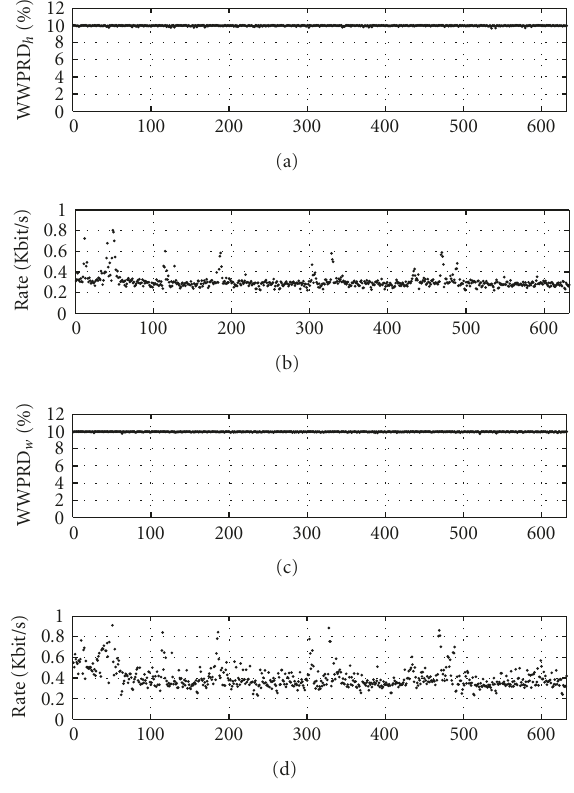
Figure 4: Quality results for record 101 of MIT-BIH Arrhythmia database is expressed block to block. (a) Target WWPRD h = 10%. (b) Rate for target WWPRD h = 6%. (c) Target WWPRD w = 10%. (d) Rate for target WWPRD w =